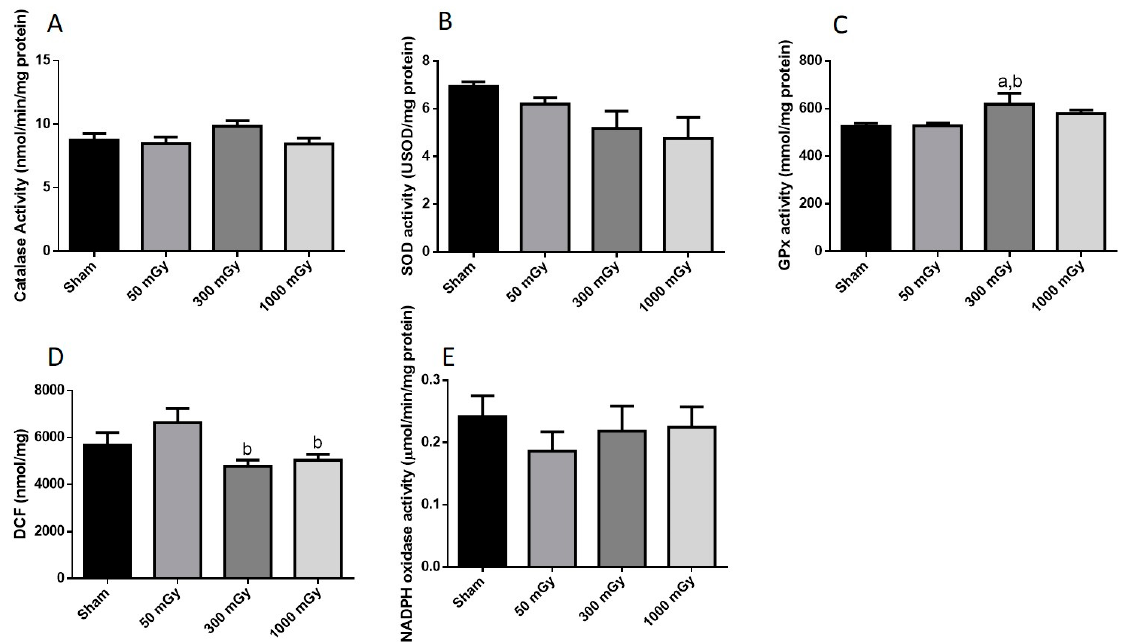
Figure 7. Antioxidant and oxidative stress status. Enzyme activity of the antioxidants ( A ) catalase, ( B ) superoxide dismutase (SOD), and ( C ) glutathione peroxidase (GPx); and ( D ) total reactive oxygen species expressed as mmol/mg of DCF; and ( E ) NADPH oxidase activity in male offspring heart tissues. Data are presented as a mean ± SEM. a—is significantly different than control, and b—is significantly different than 50 mGy, p ≤ 0.05. n = 11–13 except ( E ), n = 7–13 per group.